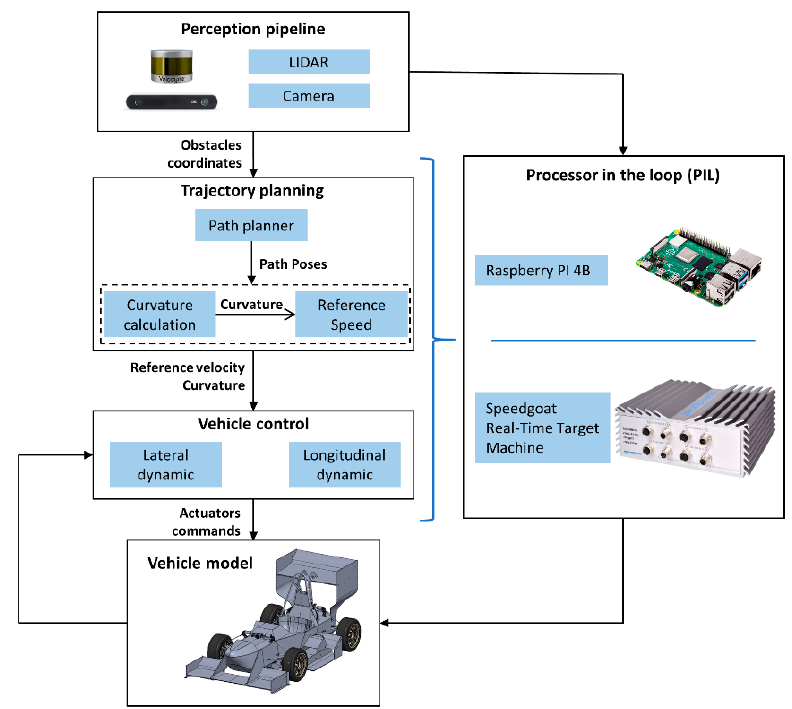
Figure 2. Overall autonomous pipeline and PIL architecture considering either Raspberry PI model 4B or Speedgoat Real-Time Target Machine model Baseline. 4B or Speedgoat Real-Time Target Machine model